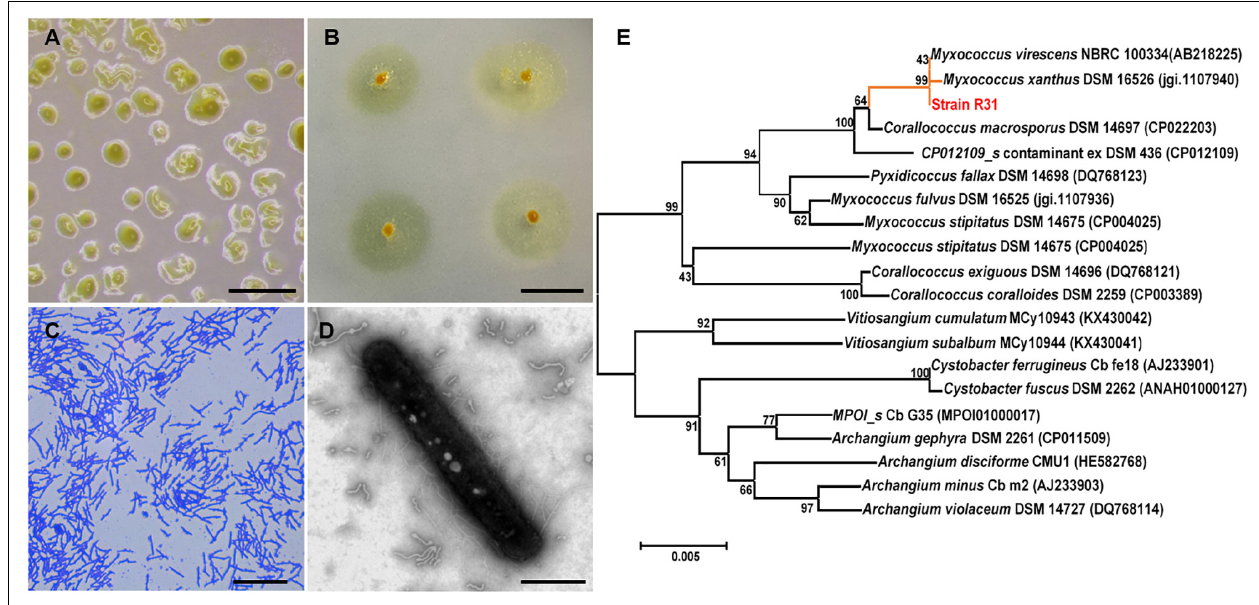
FIGURE 2 | Morphology and phylogenetic identification of the isolated Myxococcus xanthus R31. (A) Fruiting body formation of strain R31, scar bar = 0.5 mm; (B) Swarming growth of strain R31 on VY/4 medium, scar bar = 1 cm; (C) Micrograph of strain R31, scar bar = 15 µ m; (D) transmission electron microscopy (TEM) micrograph of strain R31, scar bar = 5 µ m; (E) Neighbor-joining tree of strain R31 based on 16S rRNA gene sequence.